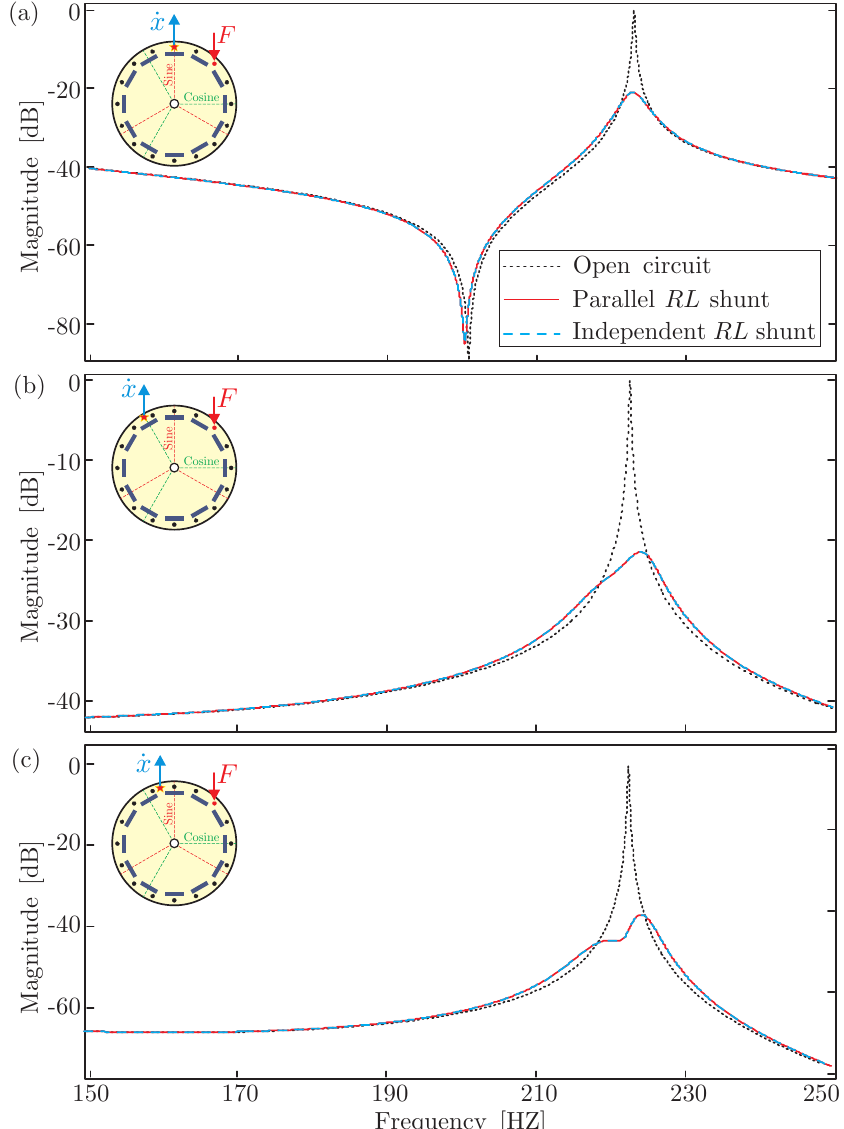
Figure 8. Simulation results: Frequency Response Function (FRF) between F and ˙ x . Comparison between the independent shunt and parallel shunt for the first mode with n = 3 nodal diameters. In all cases, the curves are on top of each other. The dotted lines correspond to the original system with a natural damping of 0.05%. ( a ) ˙ x is measured at the point where the sine mode is maximized. ( b ) ˙ x is measured at the point where the cosine mode is maximized. ( c ) ˙ x is measured in the middle where both modes contribute to the